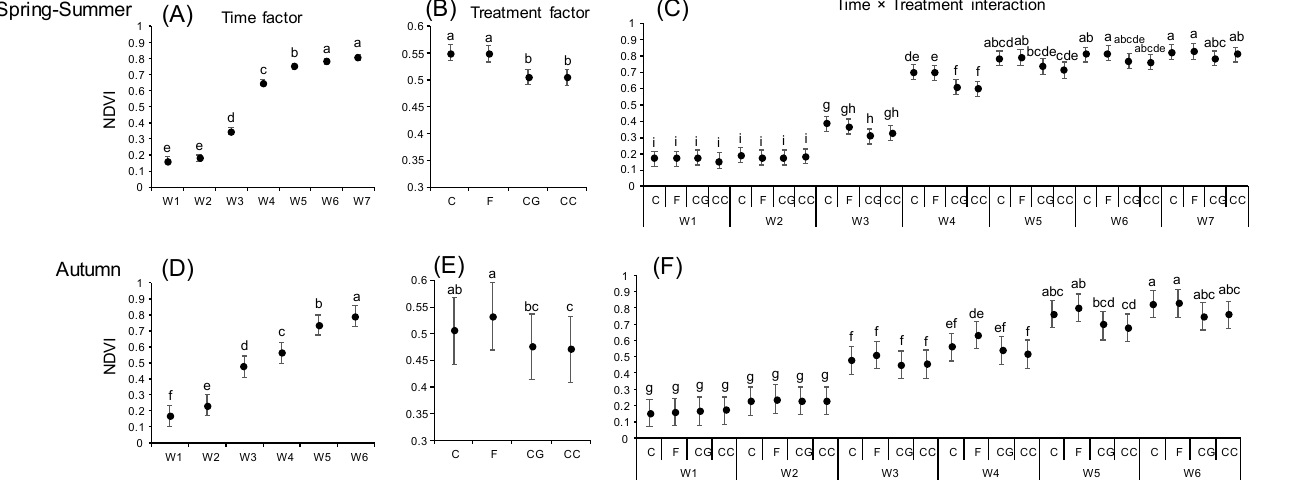
Figure 2. Effect of time (sampling week, A and D ), treatment (different waste, B and E ), and the interaction between these two factors ( C and F ) on the normalized difference vegetation index (NDVI) recorded in field experiments under Spring–Summer and Autumn conditions (Experiment 3 and 4, 2020, respectively). W1, W2,…. W7 = week 1, week 2,…, week 7 after waste incorporation. C = control, F = Vicia faba pod waste, CG = spent coffee grounds waste, CC = corn cob waste. Figures show least-square mean values (± confidence intervals). n = 4. Different letters refer to statistical significance according to significant p values from Table S2 and lsmeans function at p ≤ 0.05. In Autumn (Experiment 4), the NDVI parameter was significantly affected by treat- ment, time, the interaction between these two factors and plot as covariate (Table S2). The values of NDVI were different among sampling weeks and increased over time (Figure